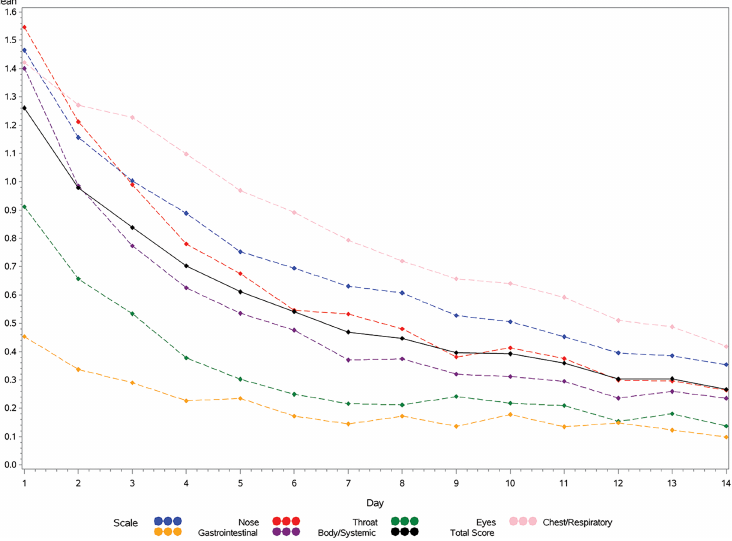
Fig 1. FLU-PRO domain and total score by diary days 1 to 14: Influenza-Negative